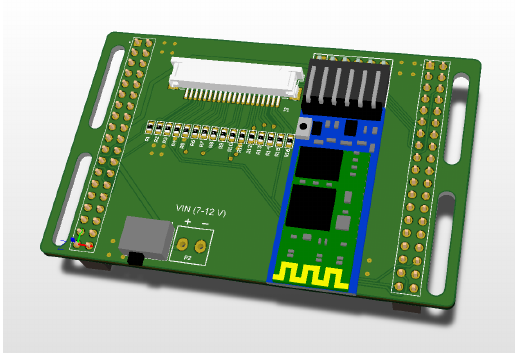
Figure 5. Design of dedicated PCB.